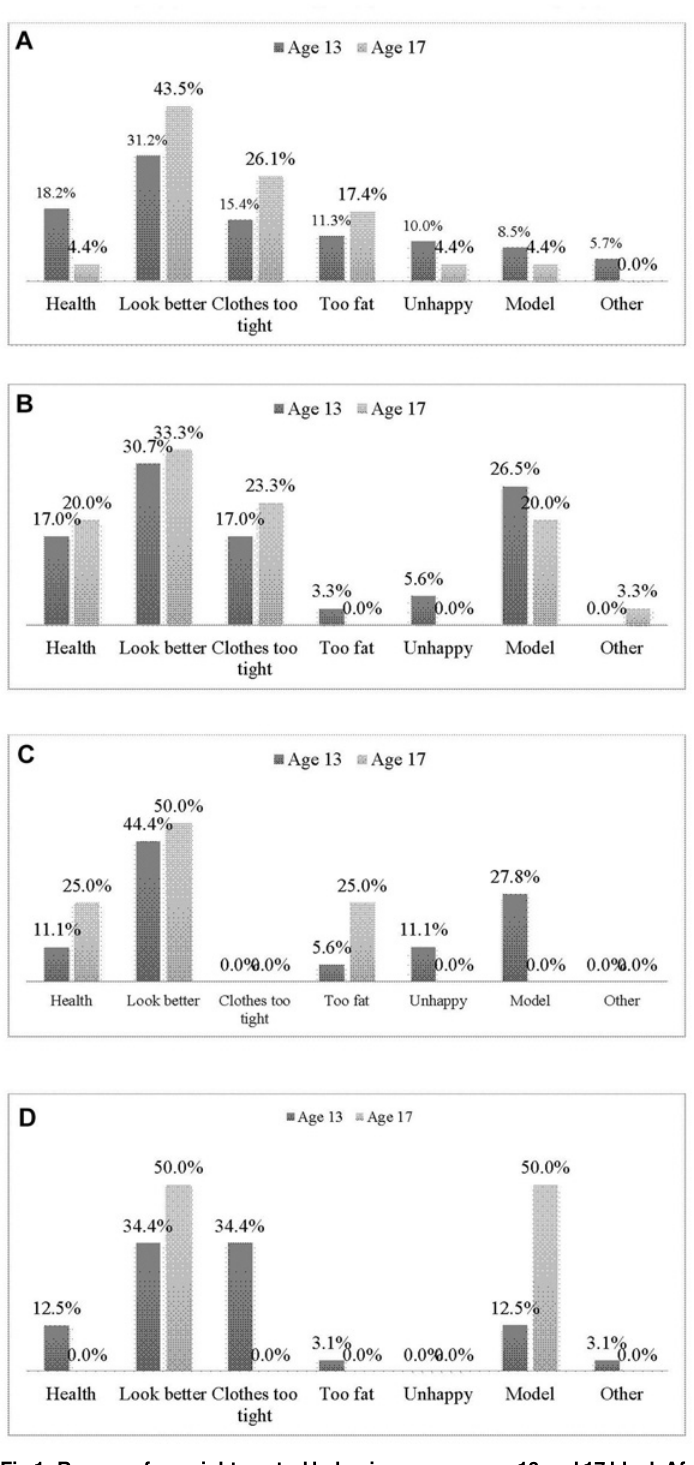
Fig 1. Reasons for weight control behaviors among age 13 and 17 black African girls (A); black African boys (B); mixed ancestral girls (C) and mixed ancestral boys (D).